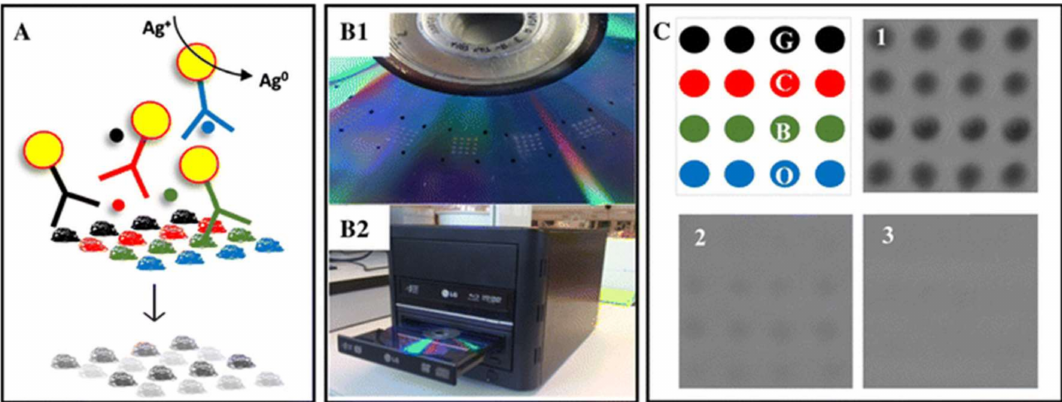
Figure 5. Scheme of a competitive microimmunoassay on DVD. ( A ) The protein allergens (gliadin, casein, β -lactoglobulin and ovalbumin) are immobilized on the DVD surface. AuNPs-labelled specific antibodies bind either to the specific immobilized allergens or to the analytes in solution (allergens). The antibody-antigen interaction is displayed as a black precipitate (grayscale) after Ag enhancement step. Each array ( B1 ) is localized by four marks made by a waterproof pen and the disc is scanned by the DVD drive ( B2 ). ( C ) Data analysis: panels 1–3 correspond to the images of the arrays for allergen concentrations of 0, 1.25 and 10 mg/L, respectively. Reprinted with permission from [91]. Copyright 2017